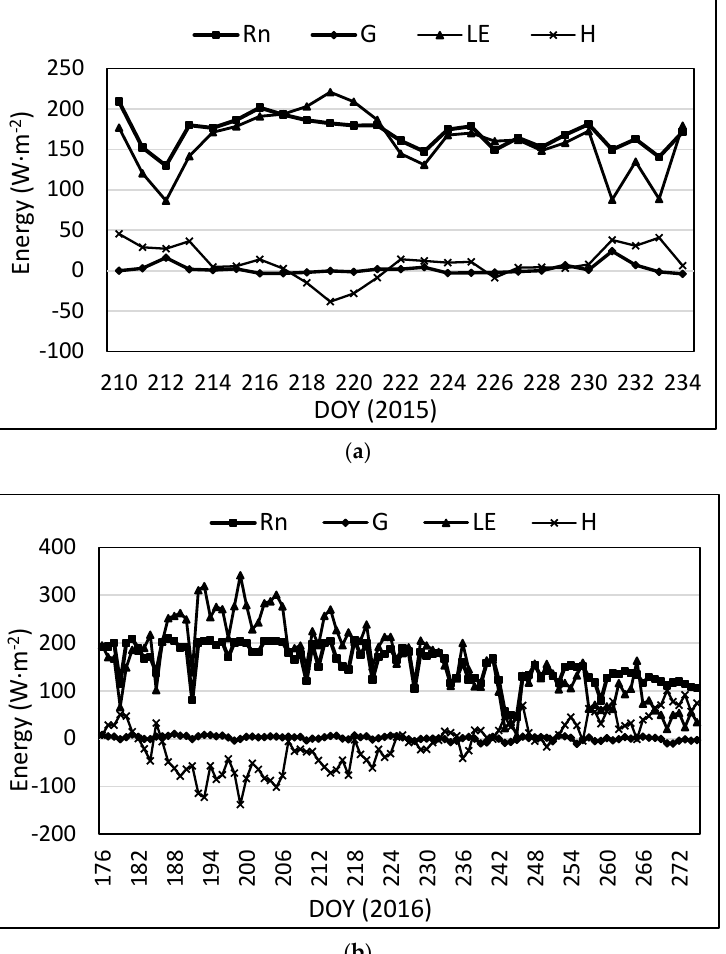
Figure 5. Average daily energy balance components for the SLS for ( a ) 2015; ( b ) 2016. The results from the statistical analyses of H showed that using the temperature gradient produced a lower error than using H sun . The assumption that the atmosphere was stable at night and unstable during the day proved to not always be true. Comparisons of H dT and H sun are presented in Figure 6. The SLS overestimated H as compared to the lysimeter, which is illustrated by Figure 6 as well as the slope of the regression equation (0.31 and 0.06, respectively). H dt from the SLS ranged from −347.7 to 475.8 W·m −2 with a mean of −5.1 W·m −2 and a standard deviation of 92.8 W·m −2 . H sun from the SLS ranged from −226.6 to 475.8 W·m −2 with a mean of 33.6 W·m −2 and a standard deviation of 93.7 W·m −2 . H determined from the lysimeter ranged from −761.7 to 426.4 W·m −2 with a mean of −11.4 W·m −2 and a standard deviation of 130.1 W·m −2 . The lysimeter showed a broader range of H values compared to the SLS, although mostly with regard to negative flux values. Although weak correlation is shown in Figure 6, the statistical analysis showed significant correlation ( p < 0.05) for all data periods (2015 only, 2016 only, and 2015–2016) for H. The regression analyses showed all slopes were significant and all intercepts were significant ( p < 0.05) with the exception of H dT for the combined 2015–2016 dataset ( p = 0.27). The measurement footprints of the lysimeter and SLS are not exactly the same. The lysimeter measures a 3 m by 3 m square whereas the SLS measures an average across the 100 m path, which is 25 m north of the lysimeter. Although care is taken to ensure the lysimeter is representative of the surrounding field, the difference in measurement footprint may contribute to the error in H.